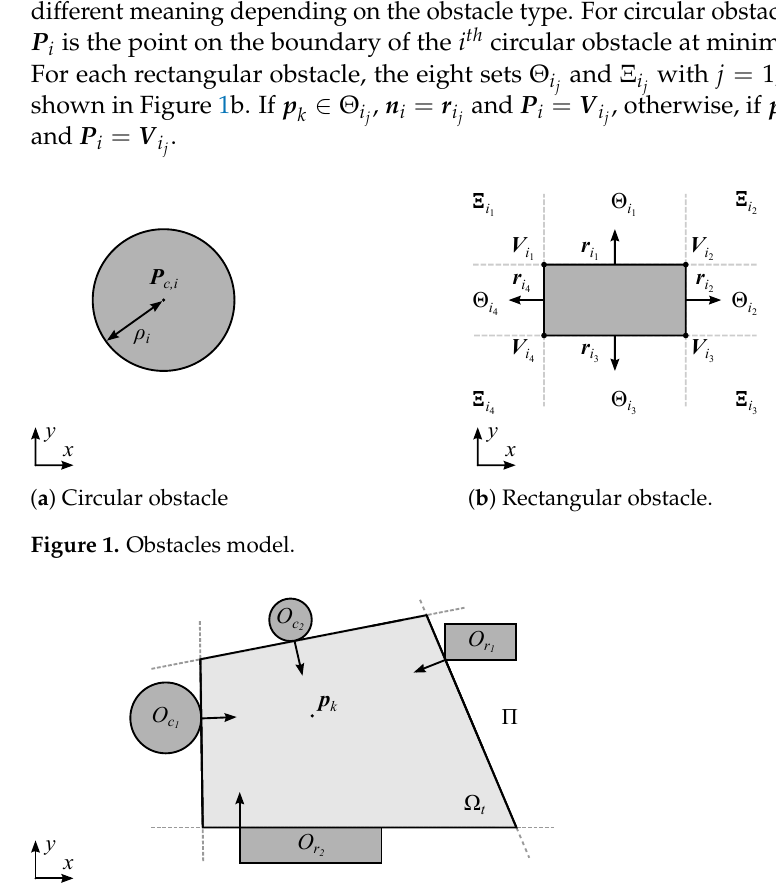
Figure 2. Example of computing the maximum convex polytope Ω t